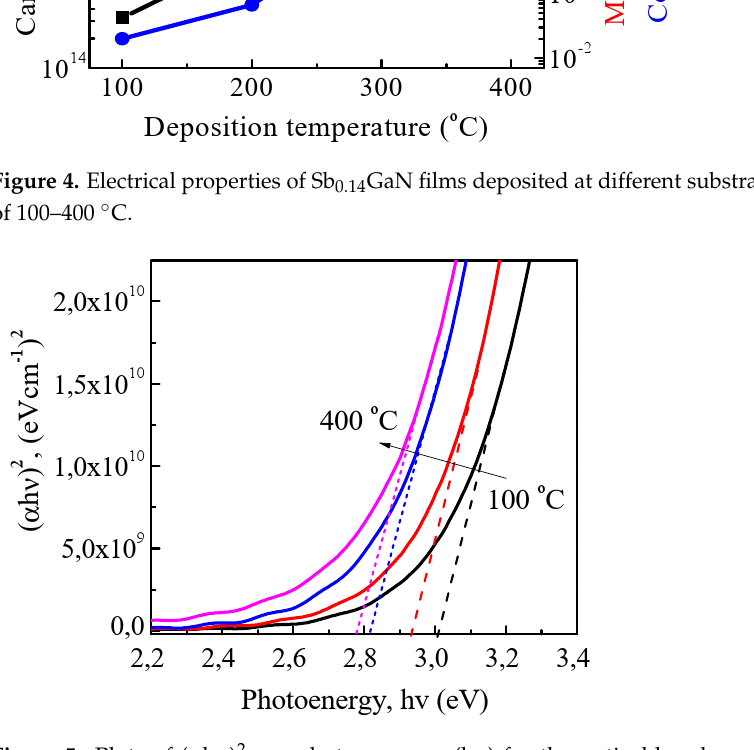
Figure 5. Plots of ( α h ν ) 2 vs. photon energy (h ν ) for the optical band gap determination of the Sb 0.14 GaN films sputtered at different substrate temperatures.